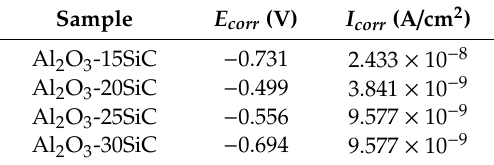
Figure 9. Tafel plots for Al 2 O 3 –SiC composites.